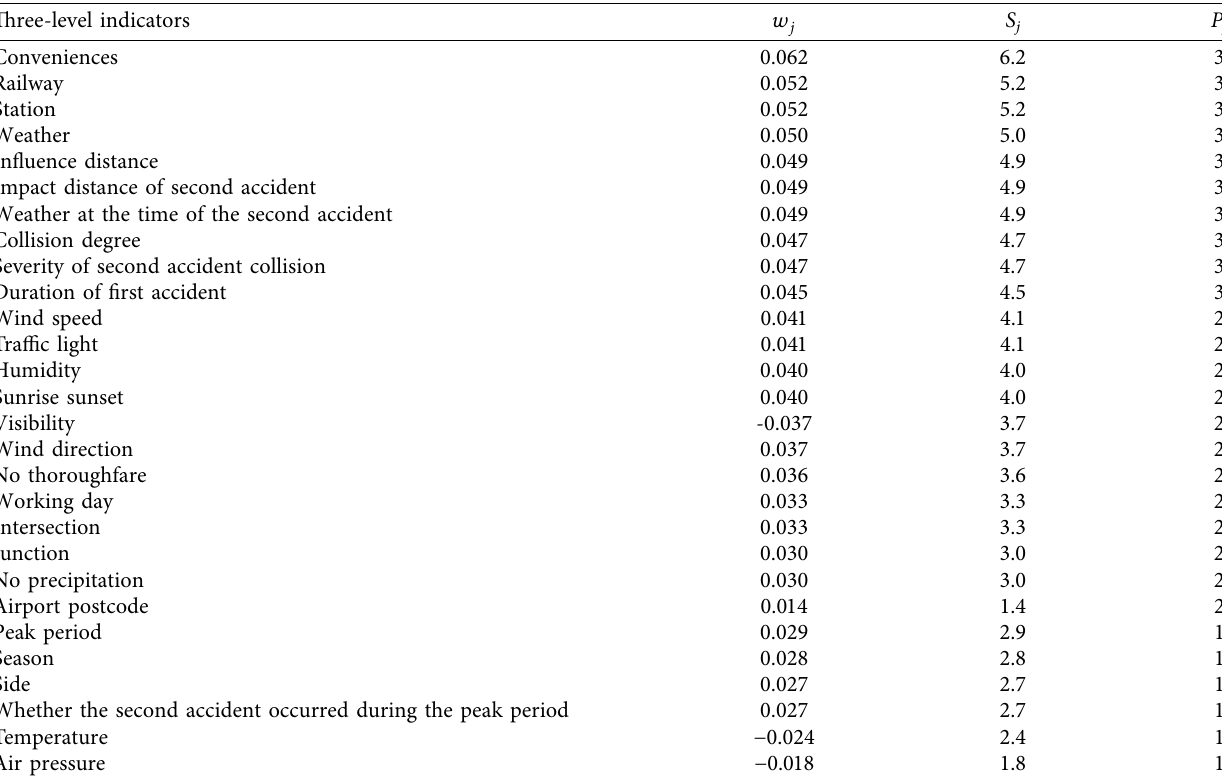
Table 4: The importance level of the weight of each variable.